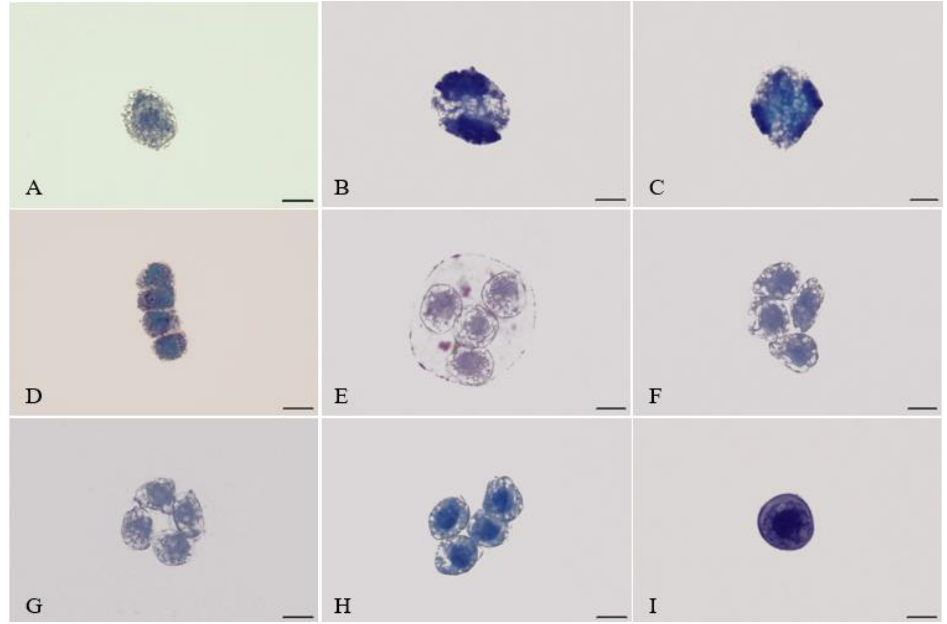
Figure 1. Stages of microsporogenesis in T. distichum var. distichum . ( A ) Microsporocyte. ( B ) Telophase I of meiosis. ( C ) Telophase II of meiosis. ( D ) Linear tetrad. ( E ) Tetrahedral tetrad. ( F ) Cross tetrad. ( G ) Quadrilateral tetrad. ( H ) The type T of tetrad. ( I ) Pollen grains. Bars: 10 μm. Table 1. The relationship between the stages of microsporogenesis and observing features of the staminate strobilus of T. distichum var. distichum.